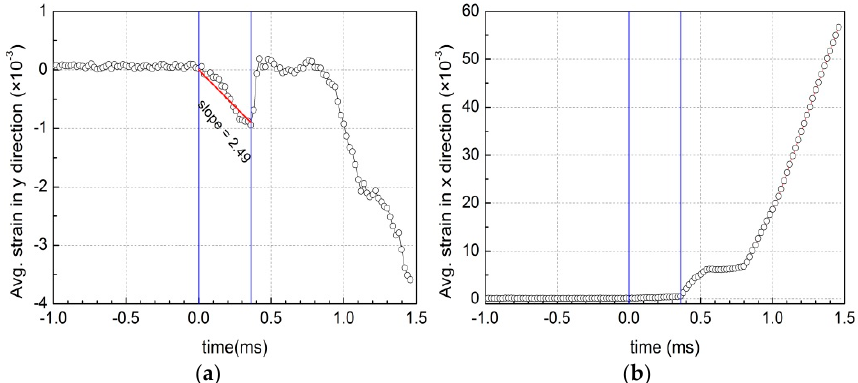
true strain-rate and true ultimate strain under different loading rates and at different temperatures are